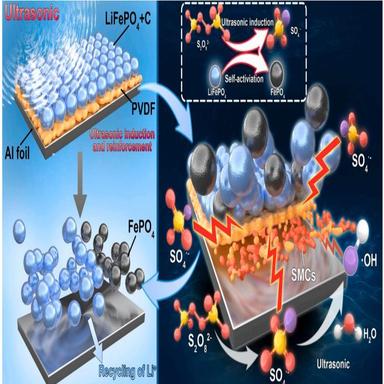
The corresponding mechanisms for the whole recycling processes (SMCs stand for small-molecule compounds).